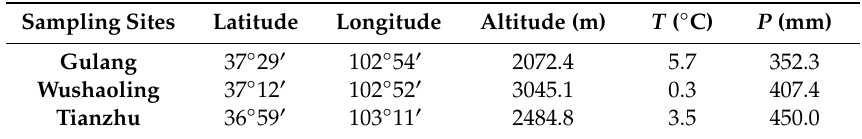
Figure 1. A map showing the locations of the sampling sites in the Qilian Mountains. The boundary of the mountainous area is marked by the black line. The satellite-derived background was acquired from Natural Earth (http://www.naturalearthdata.com). The desert areas are based on Wang et al. [18]. The inset map identifies the location of the Qilian Mountains relative to the Tibetan Plateau. Table 1. The locations and long term climatology ( T = air temperature and P = precipitation amount) during 1981–2010 at the sampling sites in the Qilian Mountains.